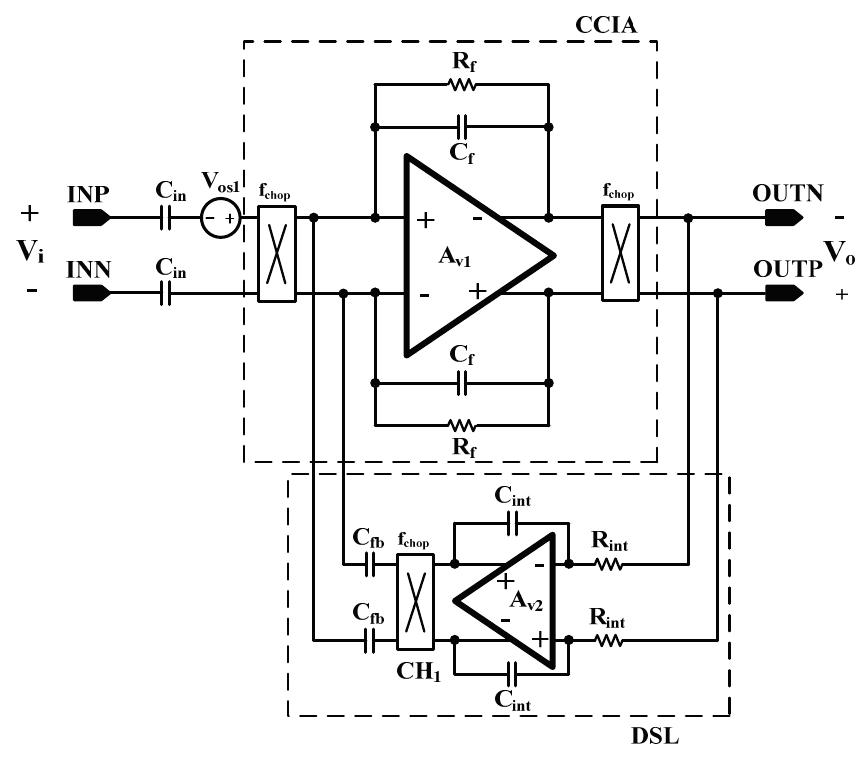
Figure 8. Schematic of the